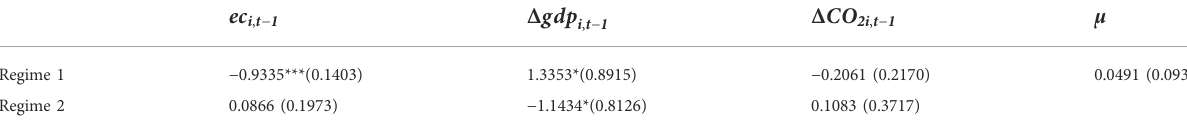
TABLE 7 Empirical results of CO 2 emissions equation when the transition variable is output growth.